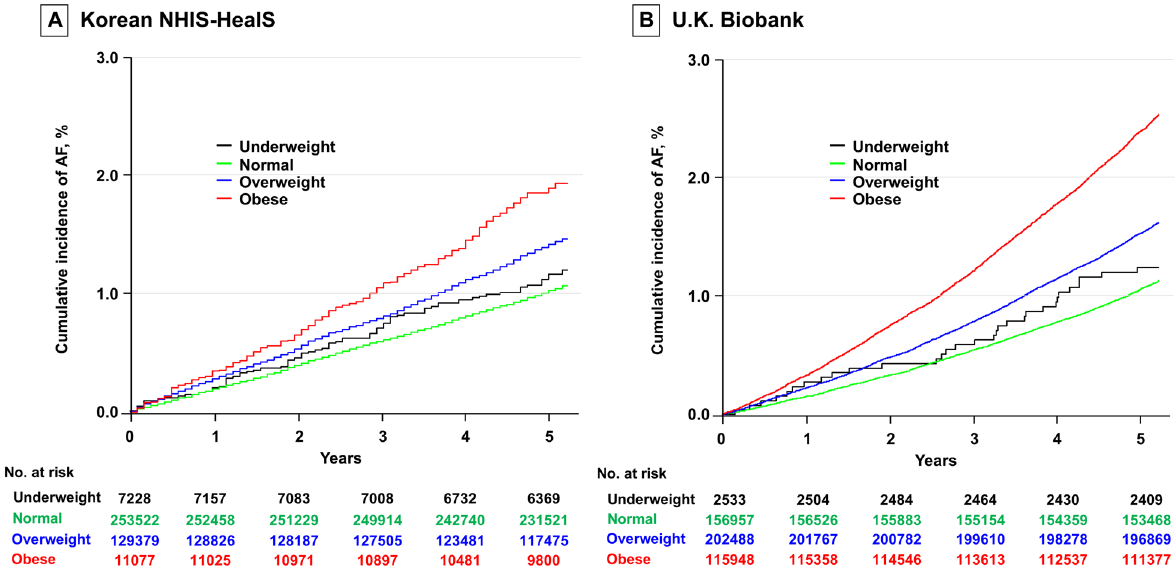
Figure 3. The cumulative incidence of AF across categories of body mass index in the Korean NHIS-HealS ( A ) and U.K. Biobank ( B ) cohorts. AF atrial fibrillation, NHIS-HealS National Health Insurance Service’s Health Screening.